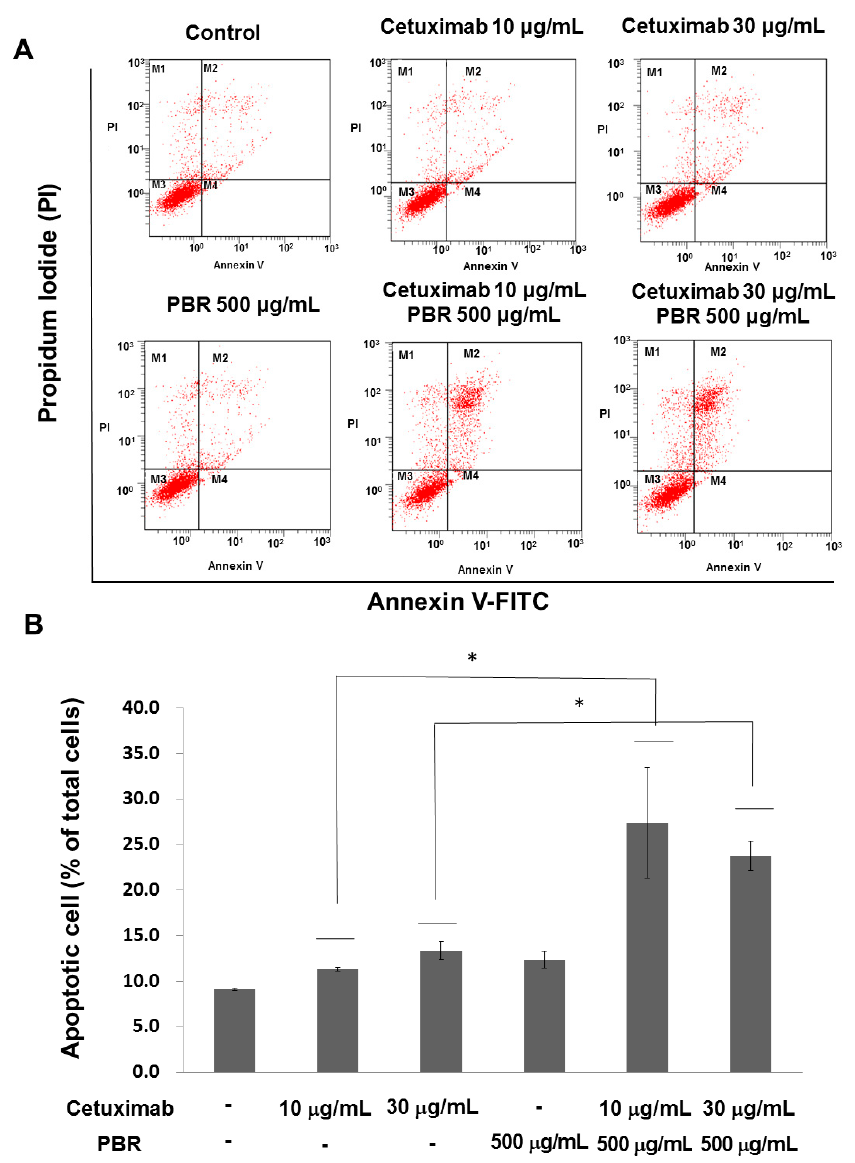
Figure 3. ( A ) Representative flow cytometry plots using Annexin V-FITC/PI staining for apoptosis. SW480 cells were treated for 48 h and were then stained with Annexin V-FITC/PI for flow cytometric analysis; ( B ) The percentage of apoptotic cells between cetuximab and the combination of cetuximab and PBR extract was statistically compared and significant differences are denoted by * ( p < 0.05). PBR, Phellinuslinteus grown on germinated brown rice; FITC, fluorescein isothiocyanate; PI, propidium iodide. Experiments are performed in triplicate and data are expressed as the mean ± standard error of the mean (SEM).